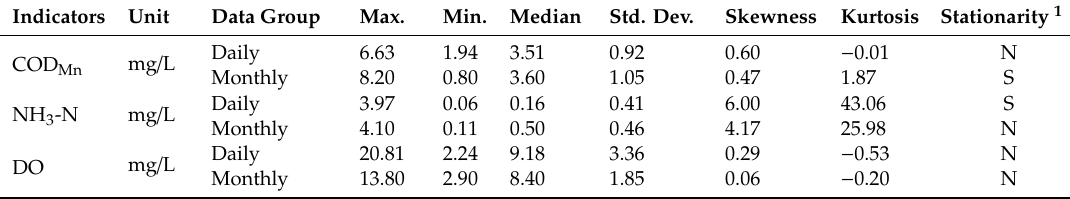
Table 1. Descriptive statistics for the measured water quality indicators at the Zhanglou site. Indicators